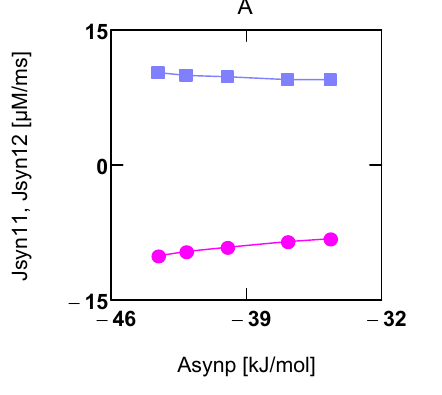
(Asynp); C: (red diamonds) Jsynp, (green diamonds) Jsynh, both versus p A SY (Asynp); D: efficiency versus force ratio ( p A A ), (open circles) results from SY simulation; (line) analytical results according to (8l); E: normalized dissipation function versus reduced force ratio x , (filled circle) result from simulation, (open circle) result from x , (line) analytical curve according to A20a; F: normalized power simulation, but at max output versus x , (filled circle) result from simulation, (line) analytical curve according to A20b; Pyr OP